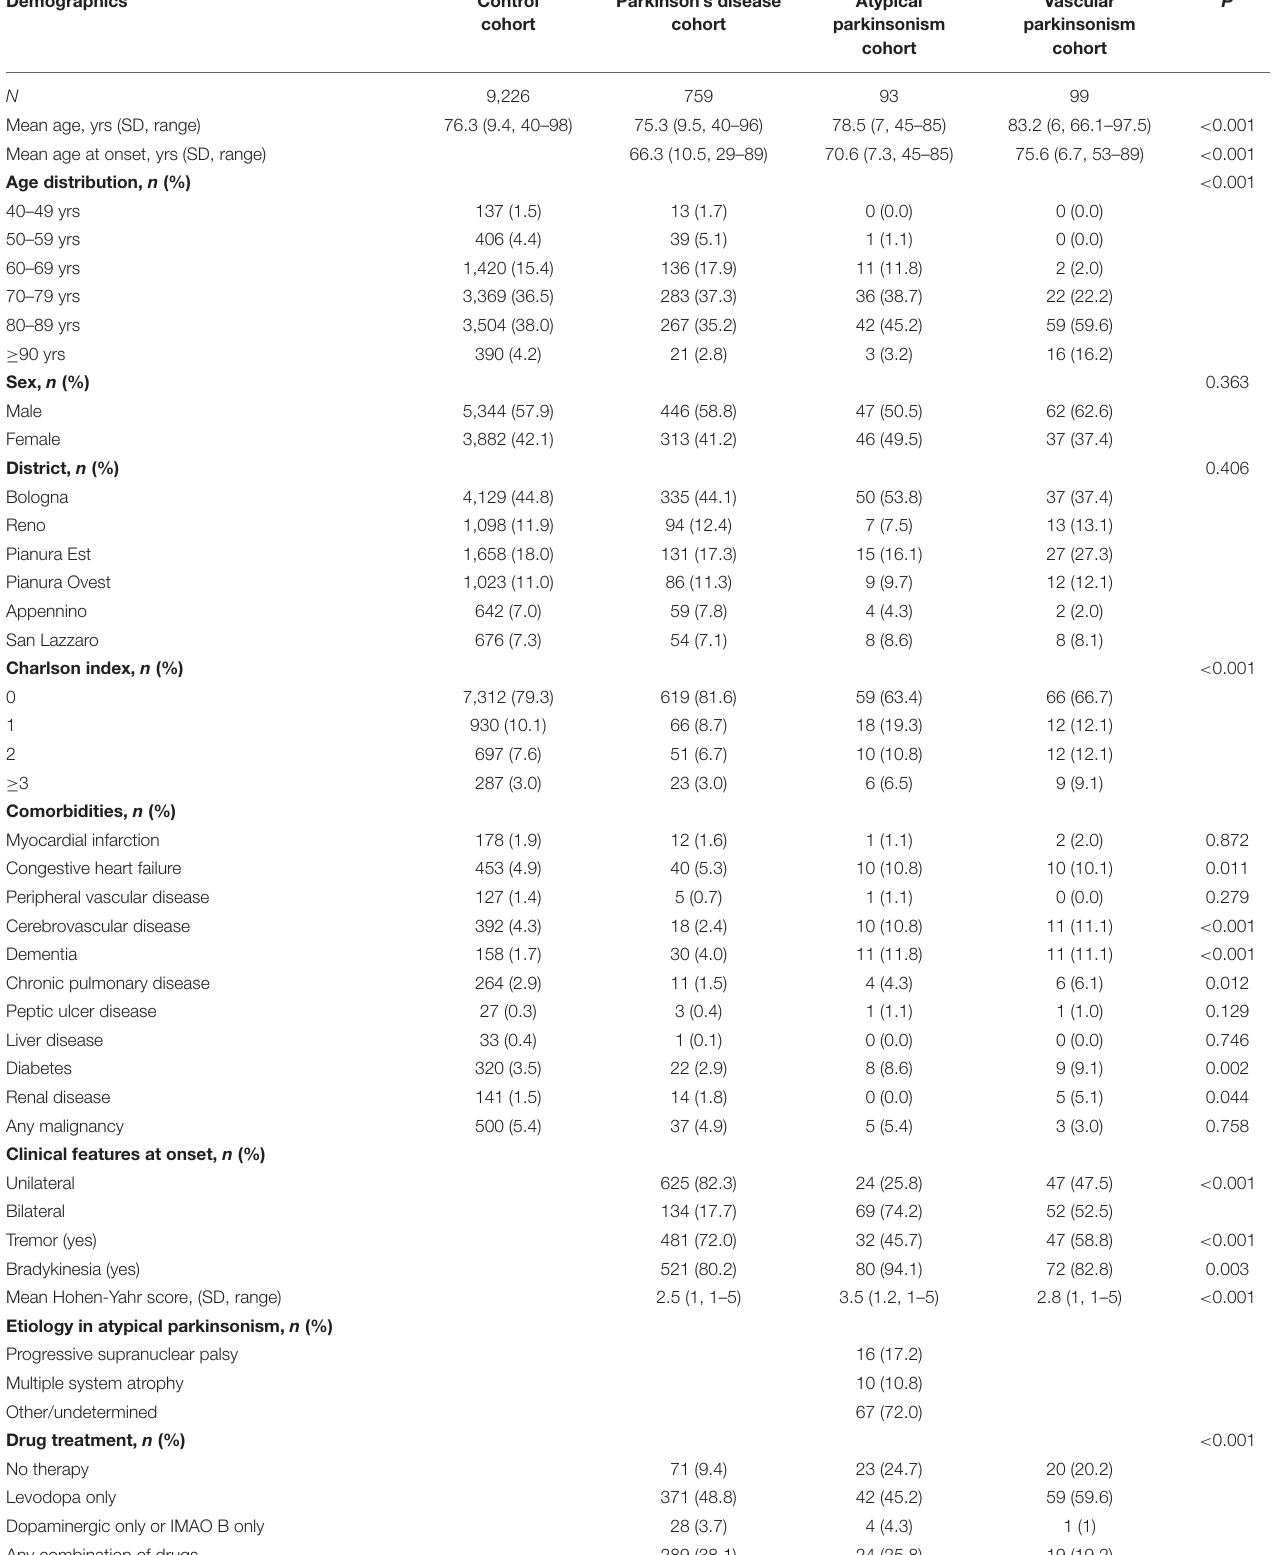
TABLE 2 | Demographic and clinical features of the ParkLink cohorts and the control cohort. Demographics Control